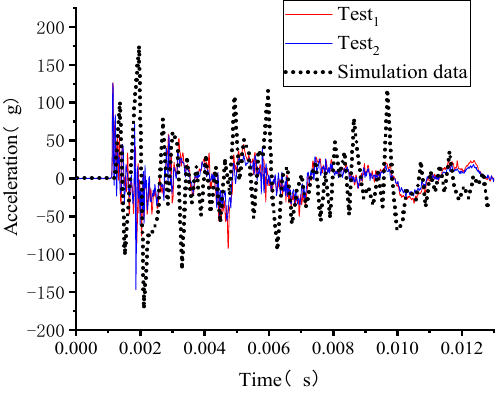
Figure 9. Dynamic acceleration measured at the inner side of the vault of member B1.